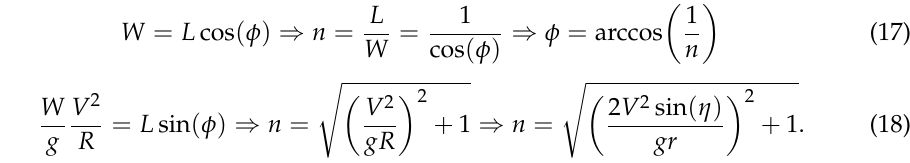
The velocity and bank angle ( η ) are assumed as constants and the flight path angle ( γ ) as null, and a symmetrical flight is also supposed, resulting in the bank and roll angles ( φ ) being equal [32]. These hypotheses, defined by the expressions (16) of uniform circular motion in the horizontal plane, are no longer true if the sideslip and flight path angles are very different from zero, but this is the best approximation for achieving a set of equations that allows one to obtain a manageable solution of the reference roll